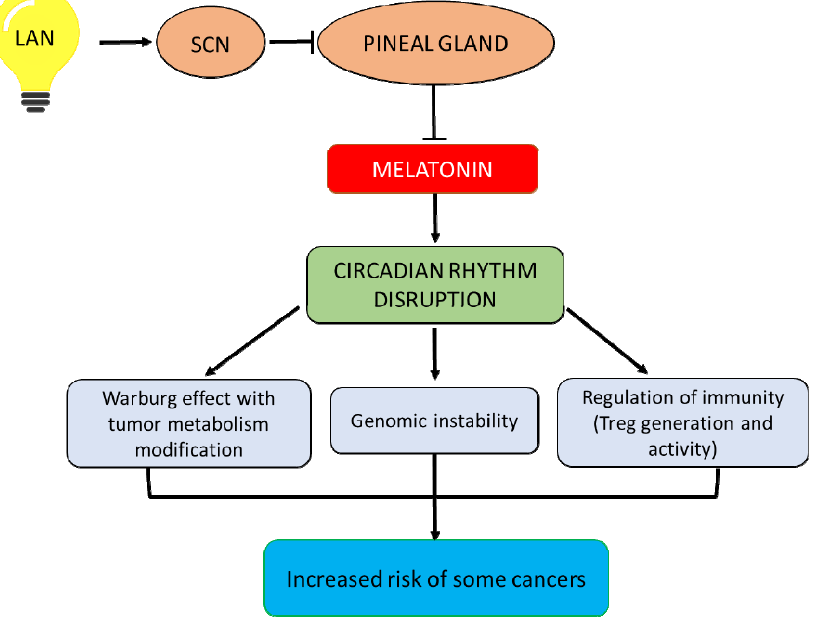
Figure 1. Artificial light exposure at night (LAN) influences the master clock present in the suprachiasmatic nucleus (SCN) of the hypothalamus. This leads not only to a decrease in nocturnal melatonin synthesis in the pineal gland but also to circadian rhythms disruption. These events can increase the risk for several melatonin-sensitive human cancers mainly through several mechanisms, including the Warburg effect related to tumor metabolism modification, genomic instability, and modification of immunity via Treg cells.